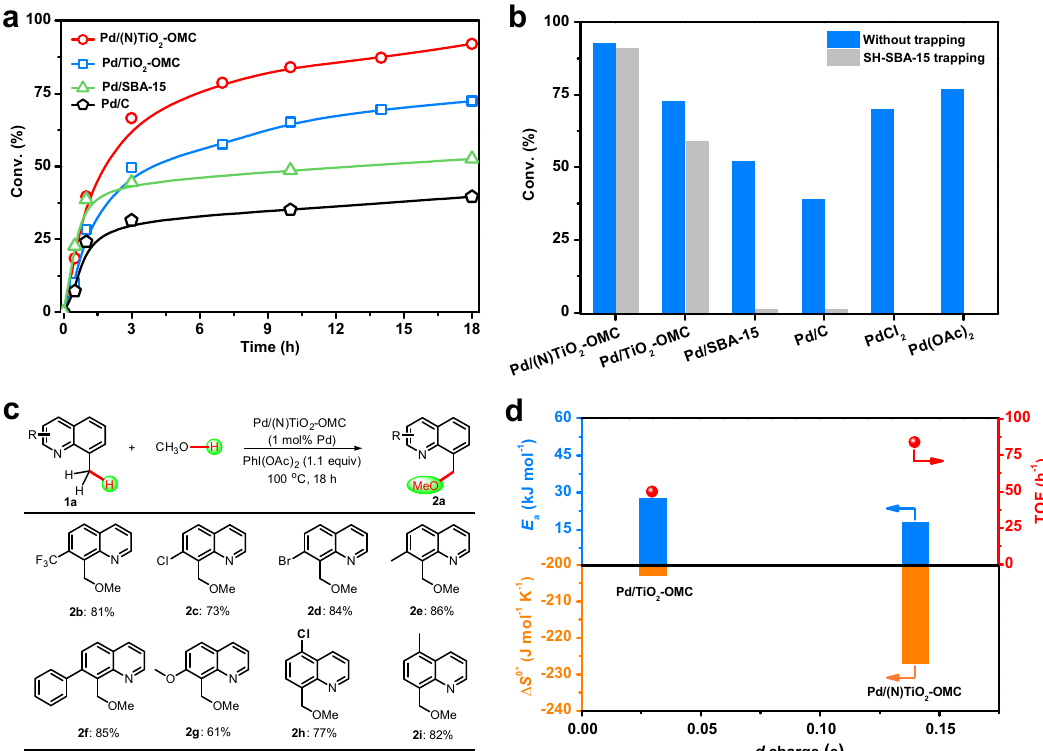
Fig. 3 Kinetics study and substrate scope. a Conversion plots for the Pd-catalyzed direct methoxylation of 8-MeQ with reaction time. b Comparison of the conversion of 8-MeQ with and without the addition of a solid SH-SBA-15 trapping agent over the various Pd catalysts (S:Pd = 35 in molar ratio). c Substrate scope of the C( sp 3 ) – H direct oxidative functionalization of quinolines catalyzed by Pd/(N)TiO 2 -OMC. d Relationship between the d- charge depletion at Pd sites and activation energy ( E a , blue bar), TOF (red sphere), and the activation entropy ( Δ S 0* , orange bar) for the direct methoxylation of 8-MeQ over the Pd catalysts supported on TiO 2 -OMC and (N)TiO 2 -OMC carriers. Reaction conditions: 0.2 mmol of 8-MeQ; 0.22 mmol of PhI(OAc) 2 ; 1 mol% Pd catalyst; 2 mL of MeOH; 100°C; 800 rpm; atmospheric pressure; in